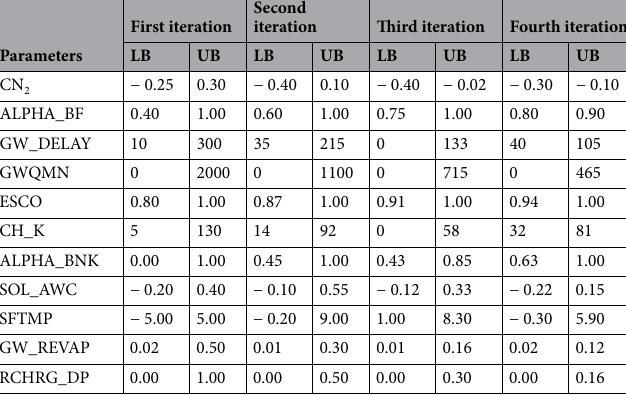
Table 5. Parameter range values of each iteration using SUFI-2.